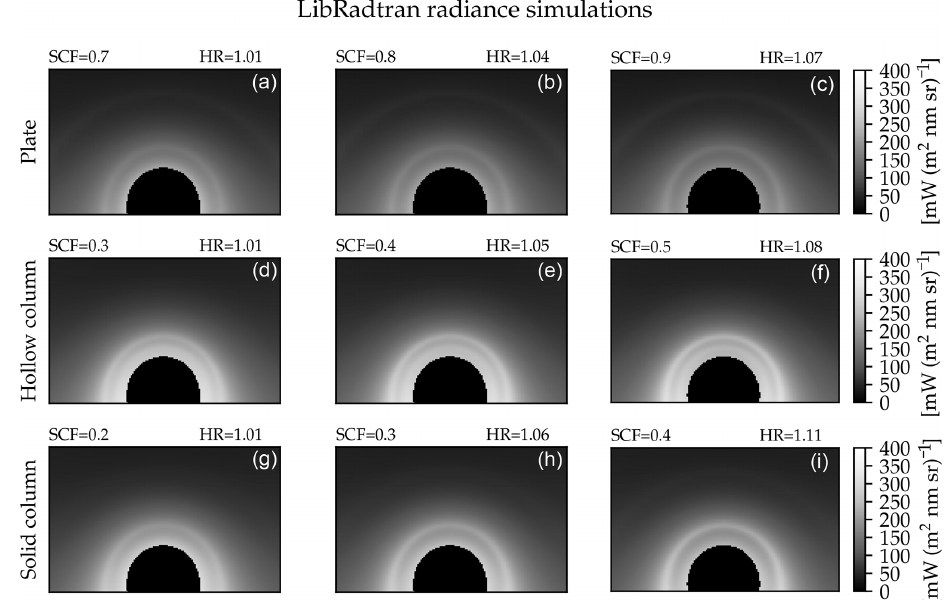
Figure 12. LibRadtran simulations using ice crystal plates (a, b, c) , hollow columns (d, e, f) , and solid columns (g, h, i) for a mixture of smooth and roughened crystals, with increasing smooth crystal fraction (SCF) from left to right. The SCF of the respective columns was chosen to achieve a similar 22 ◦ halo ratio (HR) for the three different habits. The observed HR lies between the simulated values of the left and center column. The remaining simulation parameters were kept constant: a cirrus optical thickness of 0.4 was chosen to roughly match the observed radiance values, and an effective crystal radius r eff = 20µm as a typical value for cirrus clouds was assumed. The simulations were performed for an aerosol optical thickness 0.15 with the “continental average” optical properties mixture from OPAC (Hess et al., 1998), for an average solar zenith angle of SZA = 42 . 8 ◦ , assuming an absorbing surface and using the spectral response of the red channel (cf. Fig.